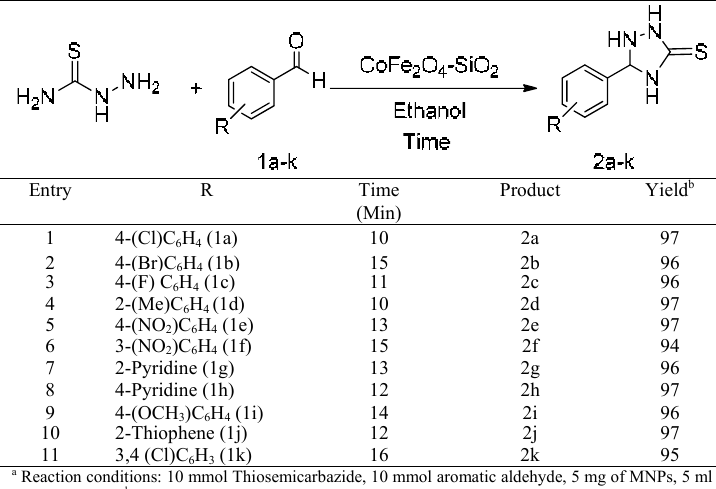
Table 5: Room temperature synthesis of 5-aryl-1,2,4-triazolidine-3-thione (a) Table 5. Room temperature synthesis of 5-aryl-1,2,4-triazolidine-3-thione (a)